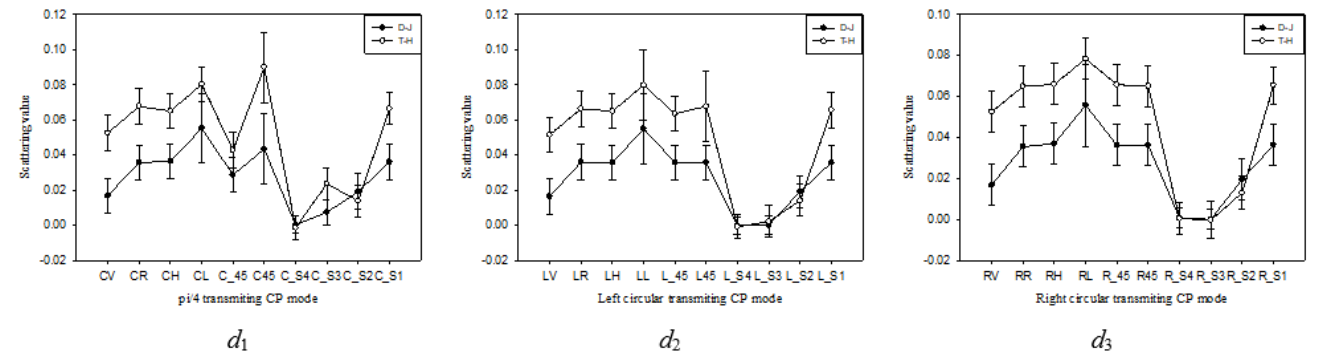
August 2015 (0823 period). 23